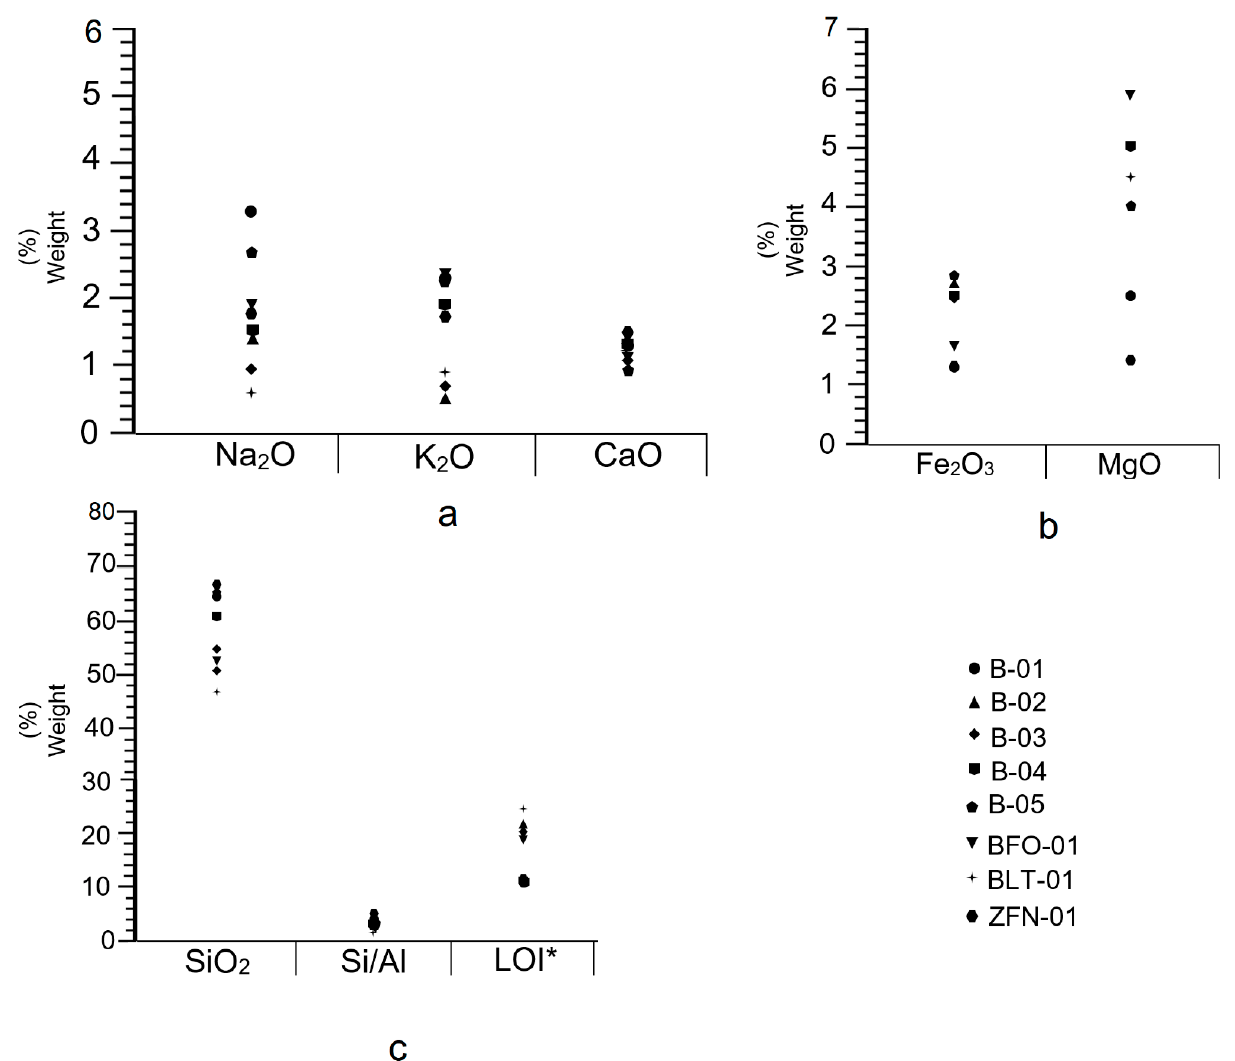
Figure 9. ( a – c ). Behaviour of alkaline, alkaline earth and other compounds in bentonites from the San José–Los Escullos deposit and surrounding areas. * Loss on ignition.